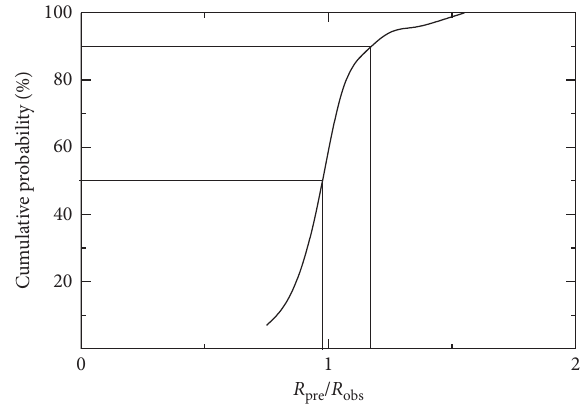
Figure 3: Cumulative probability of the ratio ( R tificial Neural Network